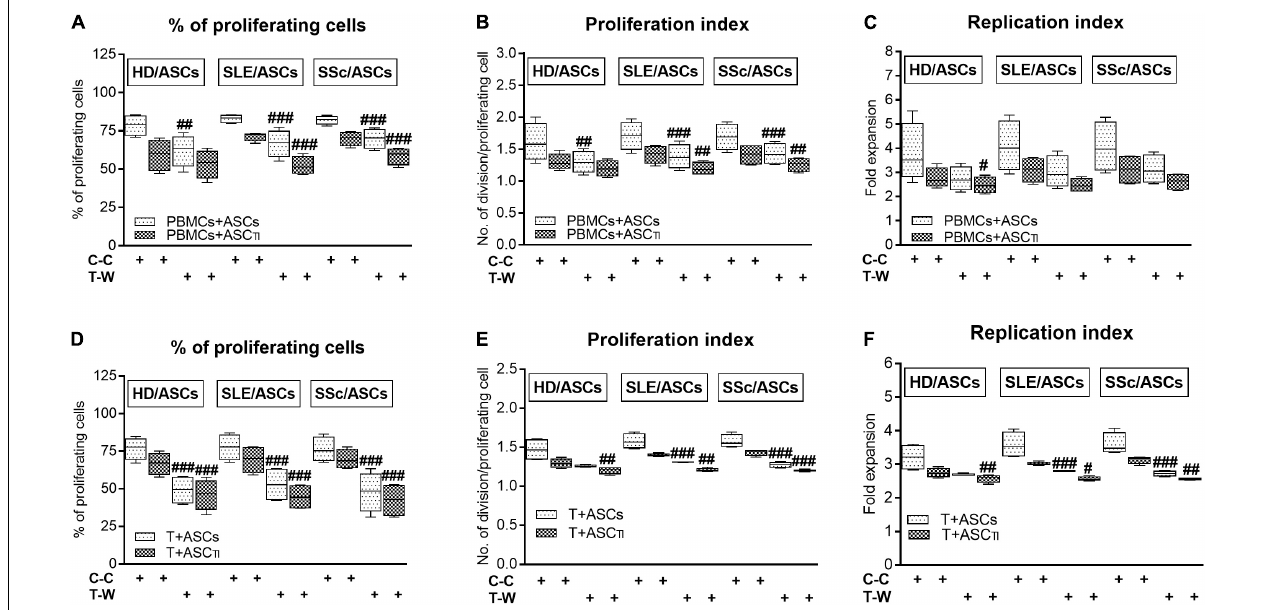
FIGURE 4 | Comparison of ASCs inhibitory effects on CD4 + T-cell proliferation in cell contact and transwell co-cultures with PBMCs and purified CD4 + T cells isolated from the same healthy volunteers. Data are shown as the Tukey’s boxes and are results of 4 experiments in which 2 HD/ASCs, 2 SLE/ASCs, and 2 SSc/ASCs lines were co-cultured with PBMCs (A–C) or purified CD4 + T cells (D–F) isolated from the peripheral blood of 2 same healthy blood volunteers. Both PBMCs and purified CD4 + T cells were stimulated with PHA. # P < 0.05, ## P < 0.01, and ### P < 0.001 for comparison of C-C versus T-W co-cultures. Other explanations as in Figure 3